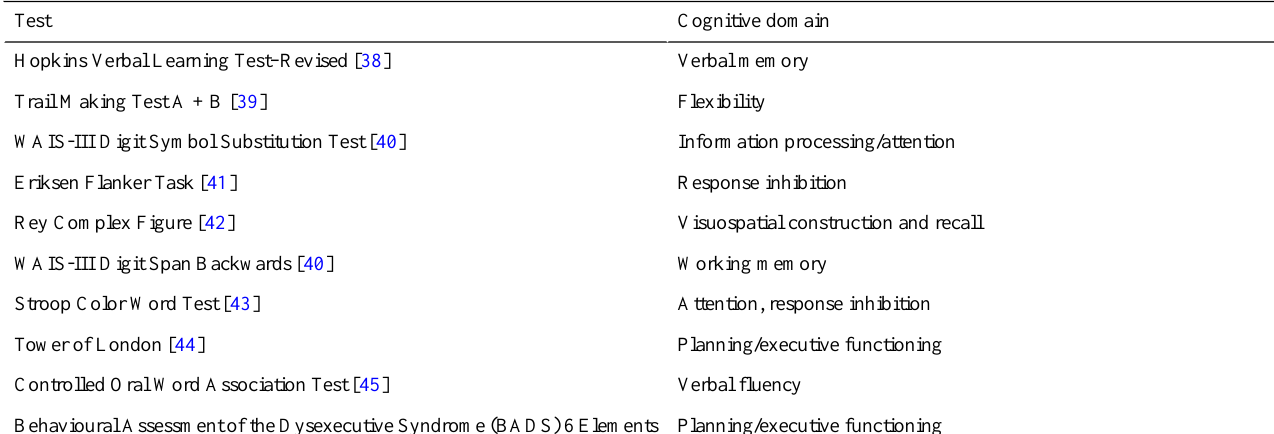
Table 2. Overview of neuropsychological test